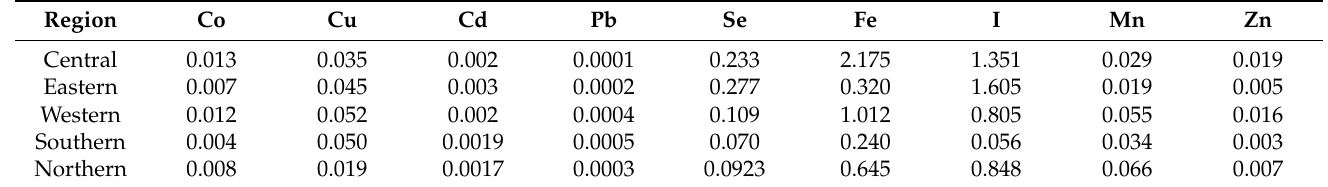
Table 2. The mineral concentration [ µ g/mL] of drinking water * for camels from the five regions.